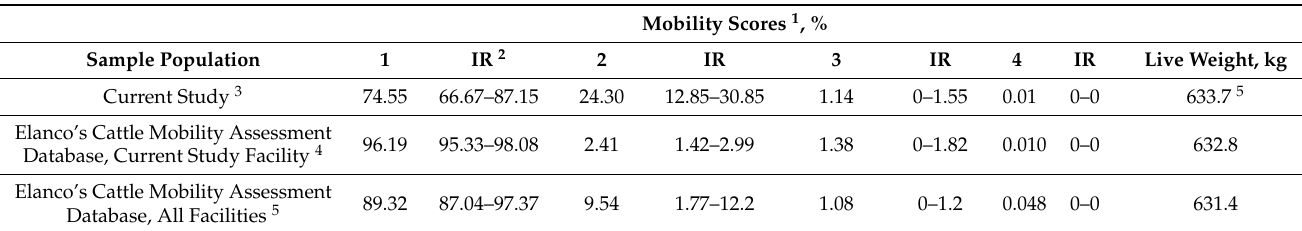
Table 4. Mean mobility scores and live weight of fed cattle from the current study and historical data from an industry benchmarking